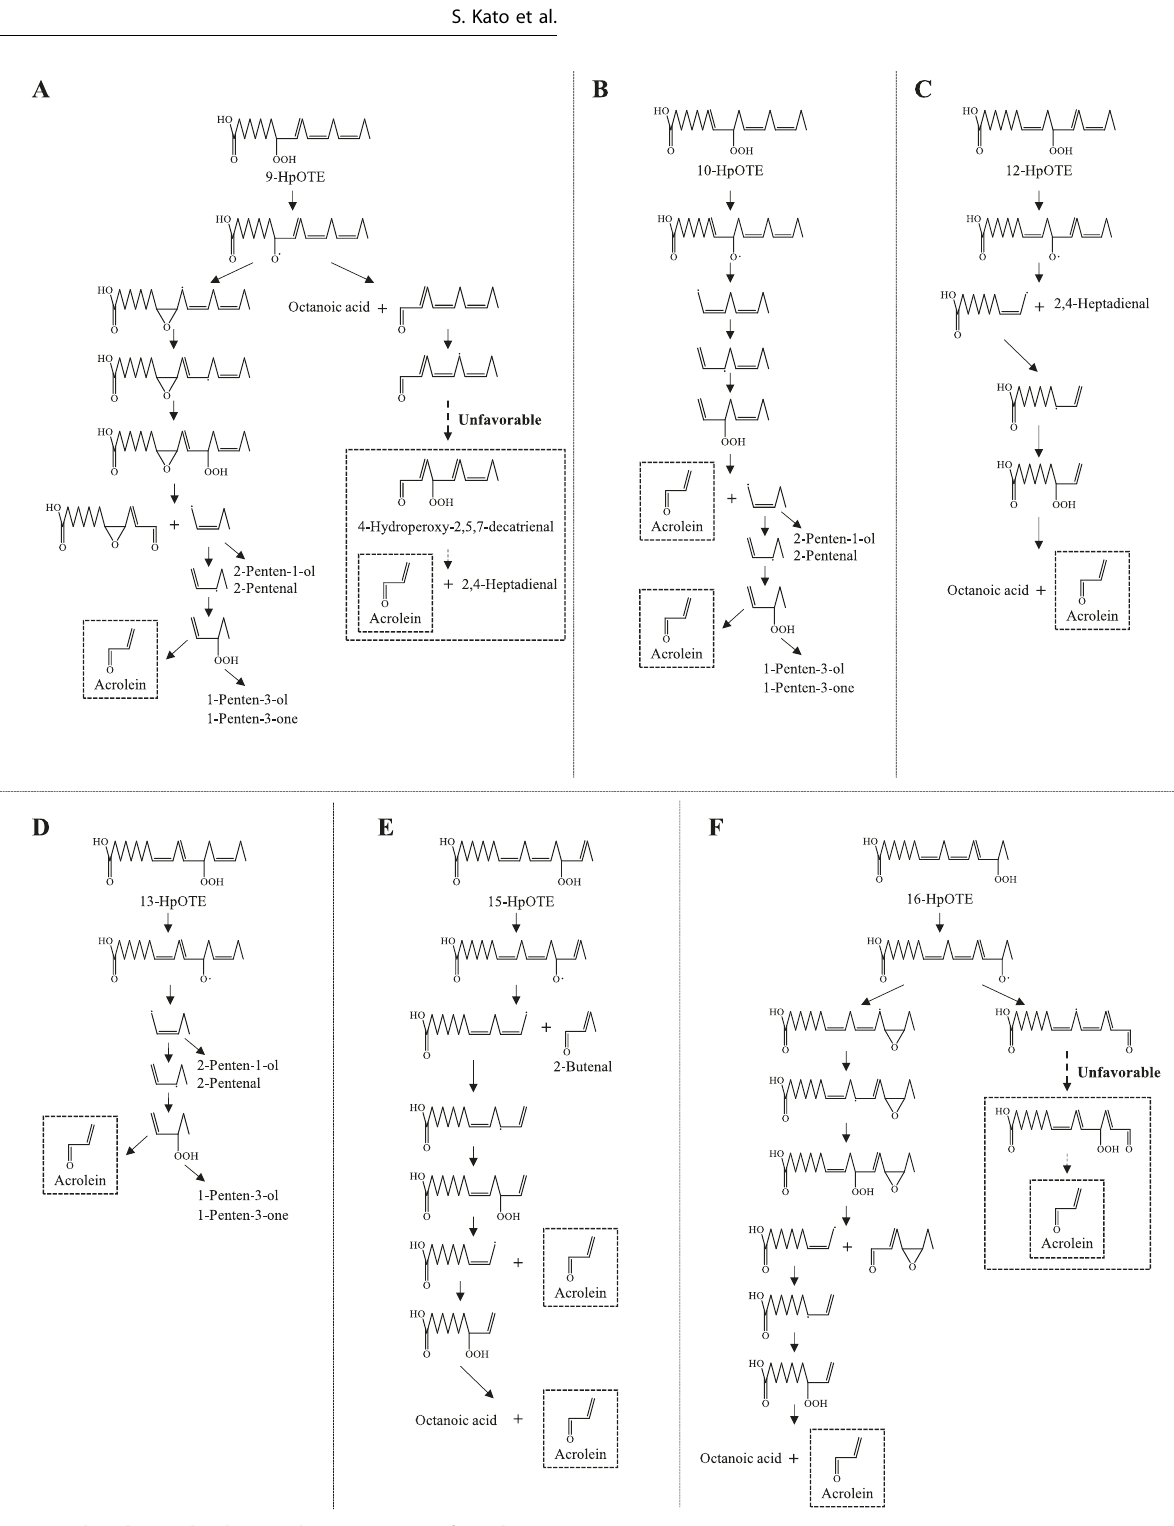
Fig. 5 Proposed pathways leading to the generation of acrolein. 9-HpOTE ( A ), 10-HpOTE ( B ), 12-HpOTE ( C ), 13-HpOTE ( D ), 15-HpOTE ( E ), and 16-HpOTE ( F